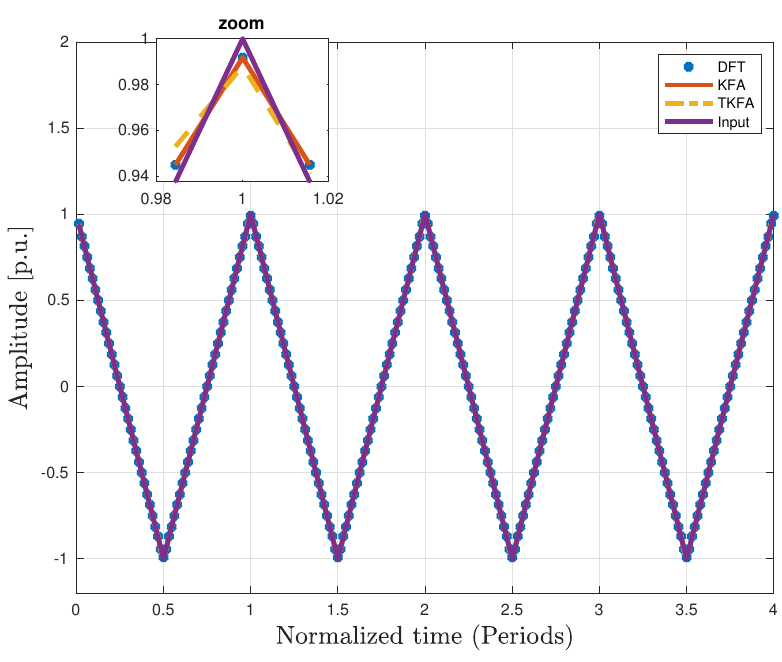
Figure 3. Reconstruction signal with DFT, KFA and TKFA algorithms. In this case, the model of KFA and TKFA was constructed with the full set of harmonics components (64 harmonics).